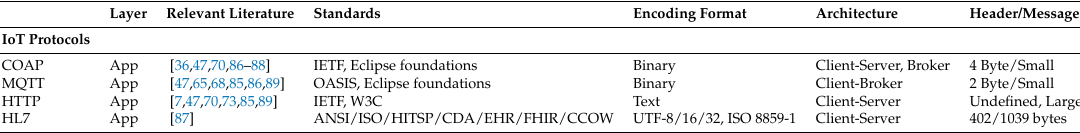
Table 3. Internet of Medical Things (IoMT) application